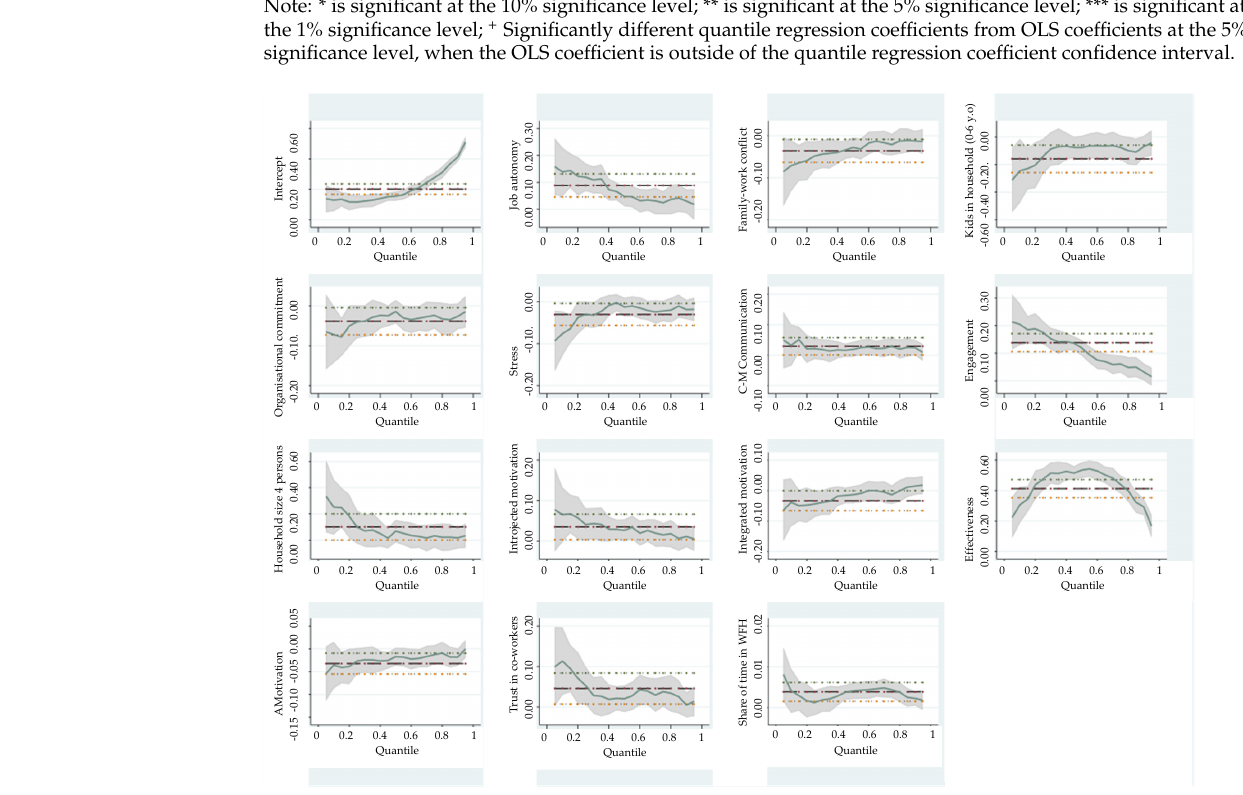
Figure 5. The influence of the WFH factors on social and technical performance.